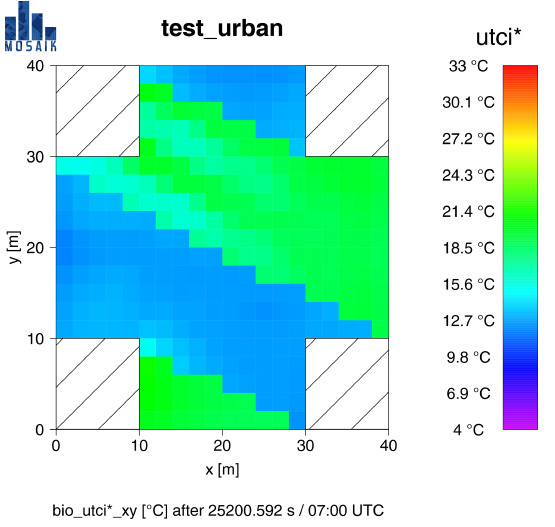
Figure 6. UTCI (utci ∗ in PALM) for the test case “test_urban” at 07:00UTC (shortly after sunrise) on 6 March.